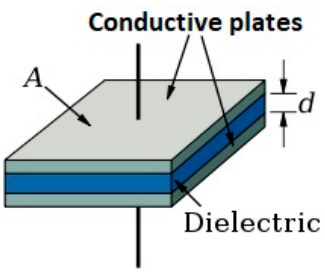
Figure 1. Capacitor structure: conductive material—dielectric material.